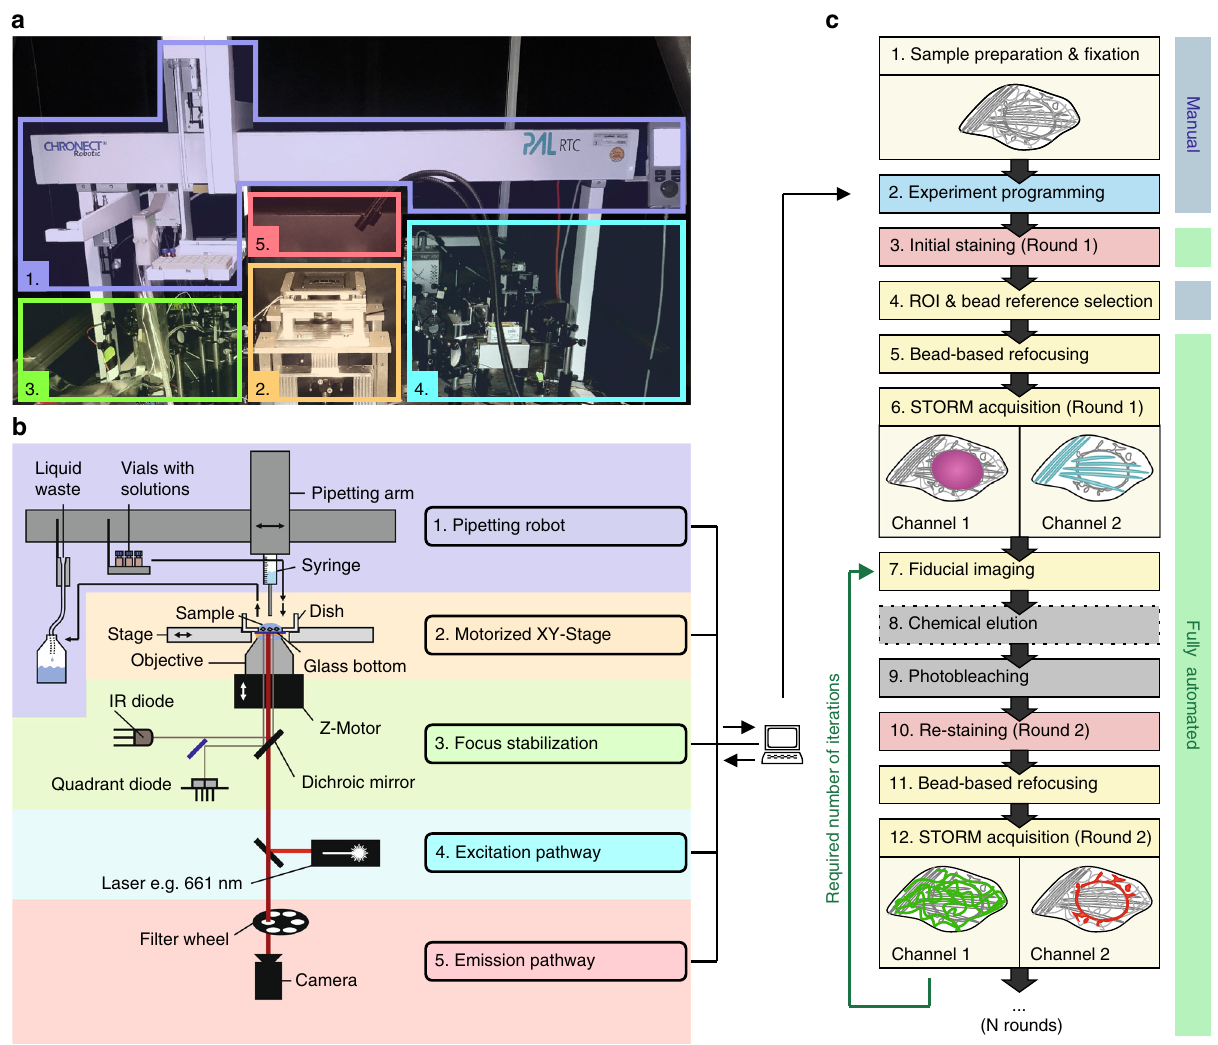
Fig. 1 Automated maS 3 TORM multiplex setup and experimental work fl ow. Photographic a and schematic overview b of the setup body comprising the pipetting robot (1, purple), the motorized stage on top of the inverted 1.49 NA 100x objective (2, yellow), the focus stabilization system (3, green), components of the excitation (4, blue) and the emission pathway (5, red). c Experimental work fl ow for an automated multiplex approach. From step 5 onwards, the work fl ow is fully automated. Step 8 is conditional (stippled line). Details on the series of steps in an automated imaging session see